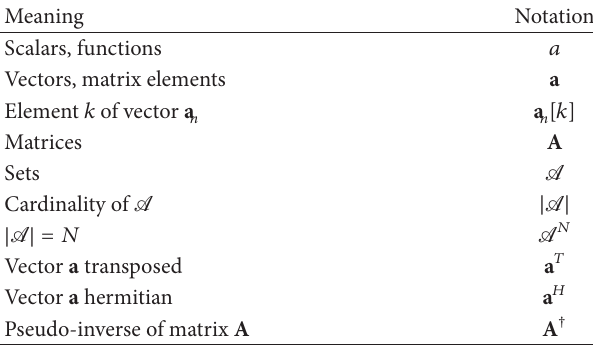
Table 2: Mathematical